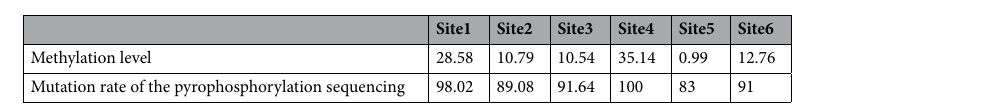
Table 3. The result of the pyrophosphorylation